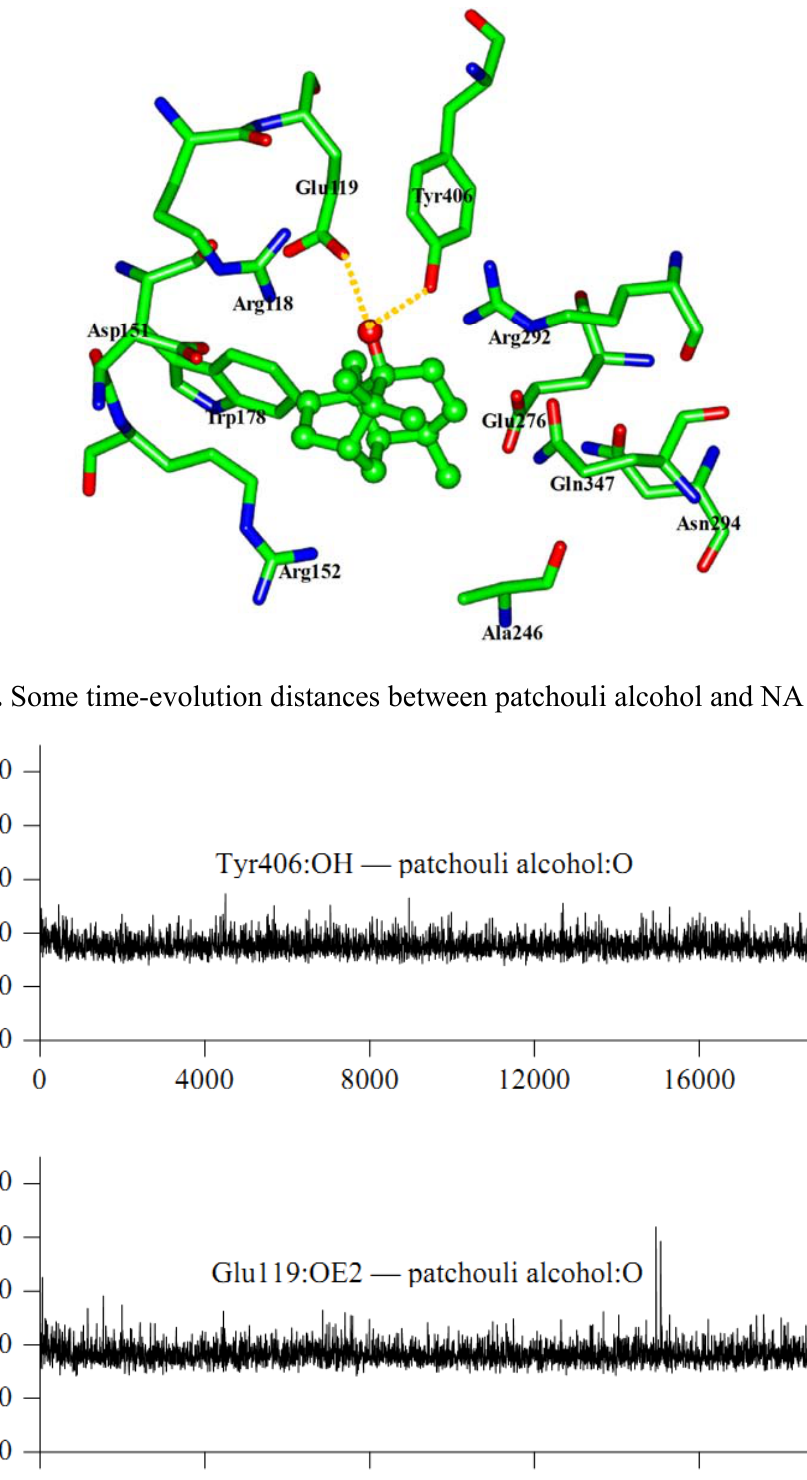
Figure 5. View of the binding mode of patchouli alcohol with the NA active-site residues. Key residues are represented by stick models. Patchouli alcohol is represented by ball and stick model. The hydrogens were avoided for readability. The important H-bonds are labeled in the dashed gold lines.